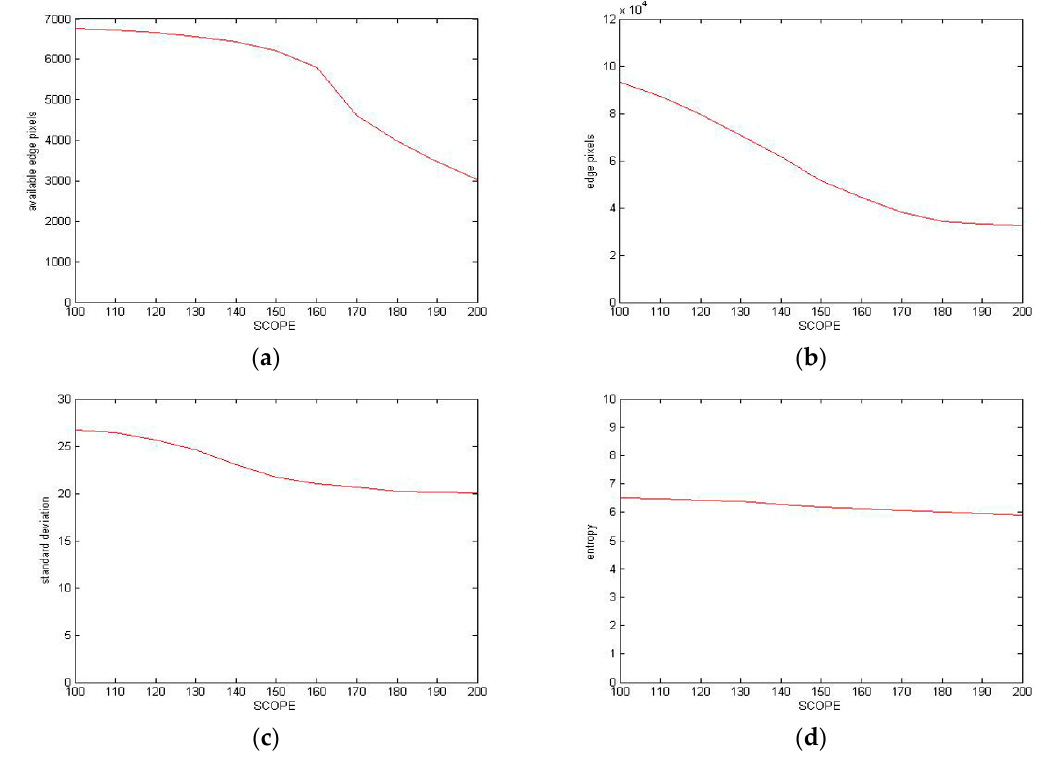
Figure 11. ( a ) The number of available edge pixels corresponding to the values of different parameter SCOPE. ( b ) The number of edge pixels corresponding to the values of different parameter SCOPE. ( c ) The values of standard deviation corresponding to the values of different parameter SCOPE. ( d ) The values of entropy corresponding to the values of different parameter SCOPE.